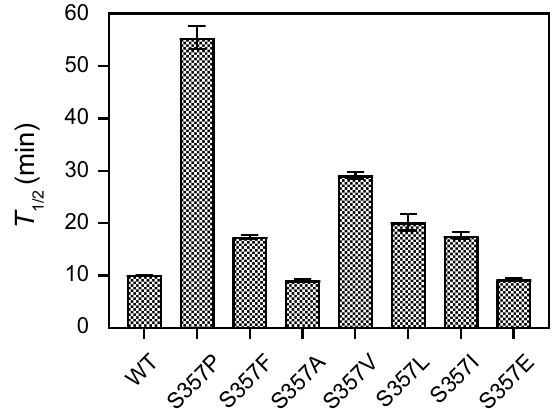
Fig. 4 Parameters of thermostability of AoDex and the active mutants. The T 1/2 values were detected at 60 °C and pH 7.0